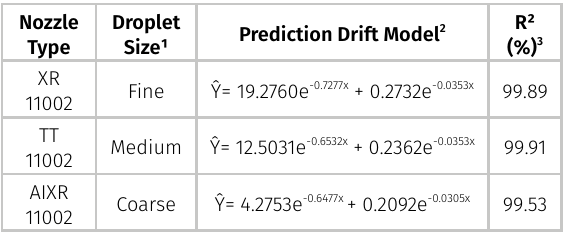
Table I. Exponential drift curve models for four parameters estimated in percentile 90 (P90) for soybean crops cultivated in